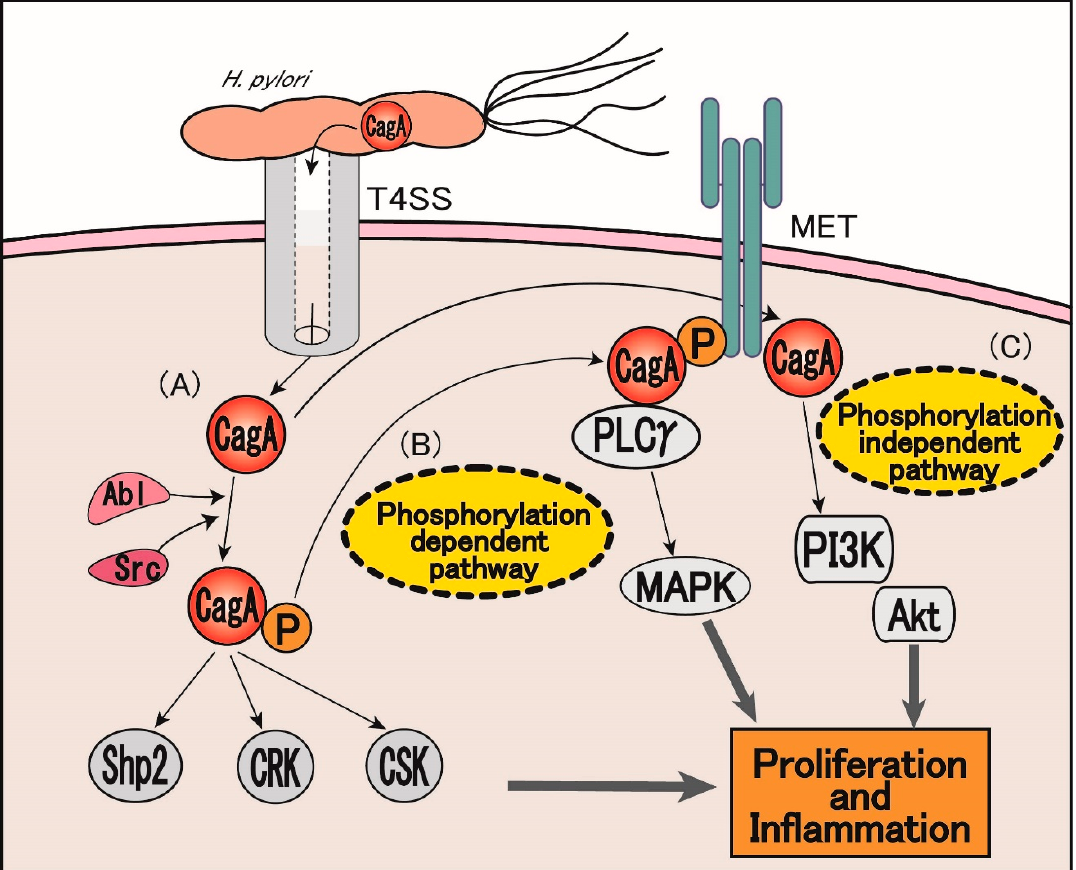
Figure 3. Induction of pro ‐ inflammatory/pre ‐ malignant response via CagA ‐ MET signaling. ( A ) CagA mediated intracellular downstream signaling in gastric cancer cells. ( B , C ) CagA/MET signaling exerts its activity via phosphorylation ‐ dependent ( B ) and phosphorylation ‐ independent ( C ) pathways. T4SS: type IV secretion system, CagA: cytotoxin ‐ associated gene A, PLC γ : phospholipase C gamma, PI3K: phosphatidylinositol ‐ 3 kinase, Akt: protein kinase B, PI3K: phosphatidylinositol ‐ 3 kinase, MAPK: mitogen ‐ activated protein kinase, CSK: C ‐ terminal Src kinase.